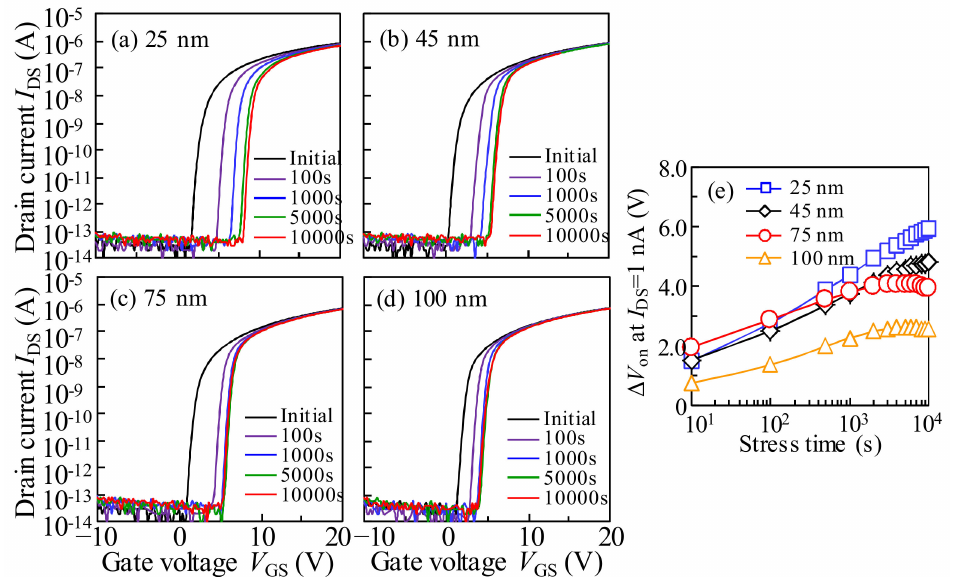
Figure 7. Evolution of transfer characteristics in the a-IGZO TFT with the T IGZO values of ( a ) 25 nm; ( b ) 45 nm; ( c ) 75 nm; and ( d ) 100 nm as a function of the drain current stress (DCS) ( V GS = V DS = 25 V) duration for 10 4 s, and ( e ) the variation in ∆ V on as a function of DCS duration for the a-IGZO TFTs with various T IGZO